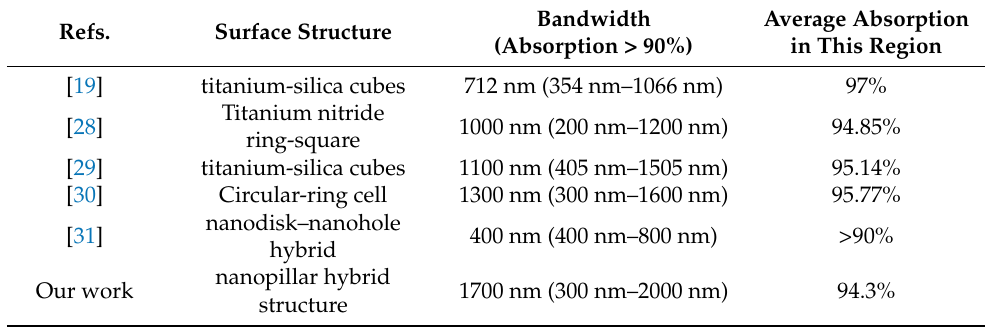
Table 3. Comparison between the different absorber designs proposed in previous studies. Refs.